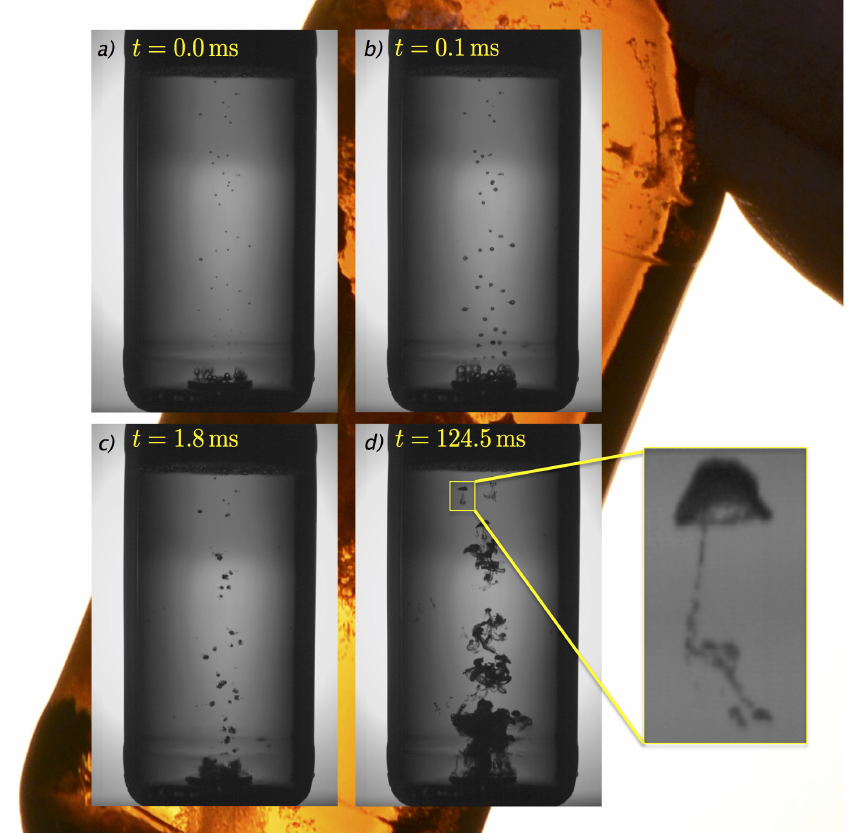
Figure 1. Different stages in the evolution of foam in the beer tapping prank. ( a ) t = 0 ms, right before the impact. Notice the presence of a metal disk at the bottom to promote the formation of a bubble column. These bubbles will act as “tracers” of the processes occurring in the bottle. ( b ) t = 0.1 ms, bubbles grow due to the sudden pressure drop and then quickly collapse, giving birth to tiny foam balls. ( c ) At t = 1.8 ms, these foam or bubble balls grow purely due to the diffusion of CO 2 into them. ( d ) At t = 124.5 ms, the flow is dominated by buoyancy-driven bubbly plumes like the one shown in the inset. The relative motion between these plumes and the liquid greatly enhances mass transfer, and thus most of the foam is generated in this